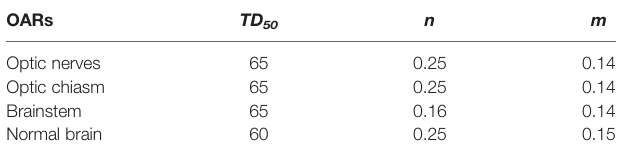
TABLE 2 | Normal tissue tolerance parameters for calculation of